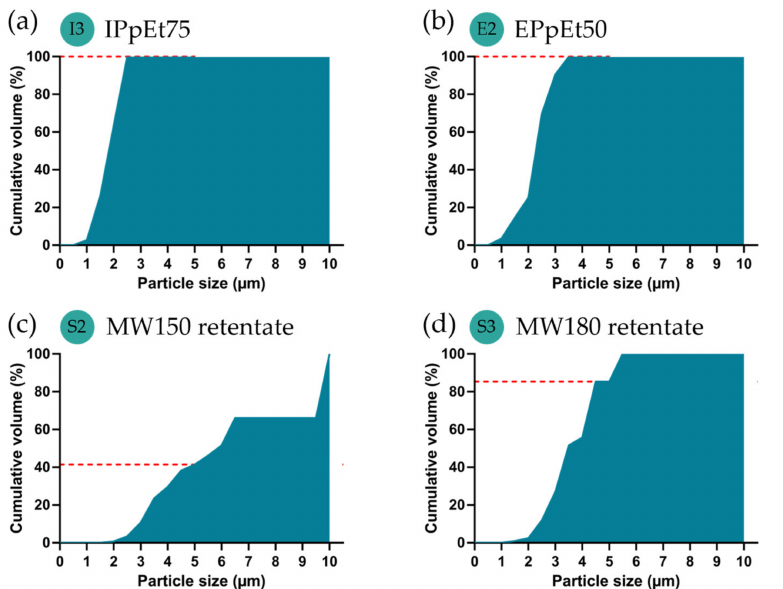
Figure 5. Cumulative volume determined based on the particle size for microparticles made